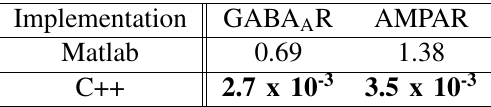
TABLE VI: Run times (seconds) for the Mat- lab and C++ Radau method when solving the GABA R and AMPAR A